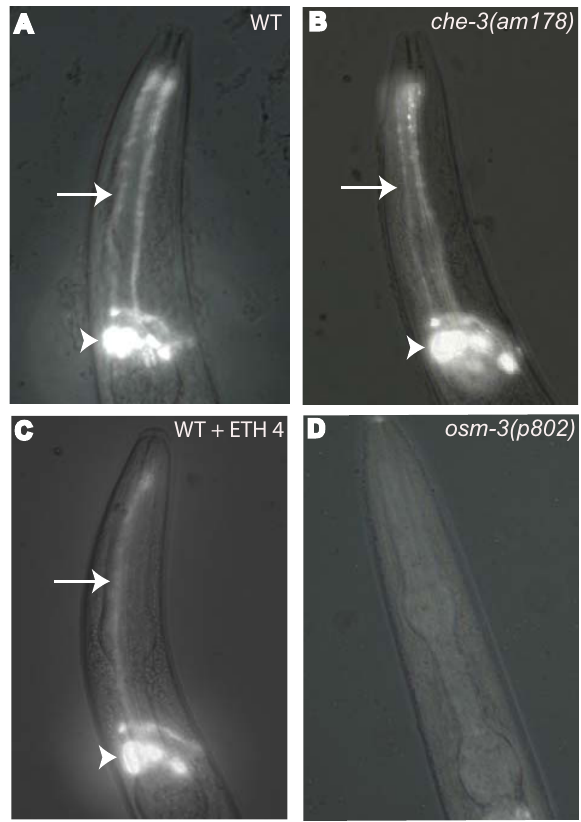
Figure 3. Ethosuximide treated animals and che-3(am178) mutants cultured at 20 u C did not display dye-filling defects. Animals were incubated in the lipophilic dye DiO and observed using fluorescence microscopy at 200 6 magnification. Each panel illustrates the anterior tip of the animal (top) to the base of the bi-lobed pharynx (bottom). DiO stains amphid neuron processes (arrows) and cell bodies (arrowheads). Wild-type (WT) animals displayed robust staining that was not affected by treatment with 4 mg/ml ethosuximide (WT + ETH4). che- 3(am178) mutants cultured at 20 u C displayed robust staining, whereas osm-3(p802) mutants displayed no detectable staining (the Dyf phenotype).